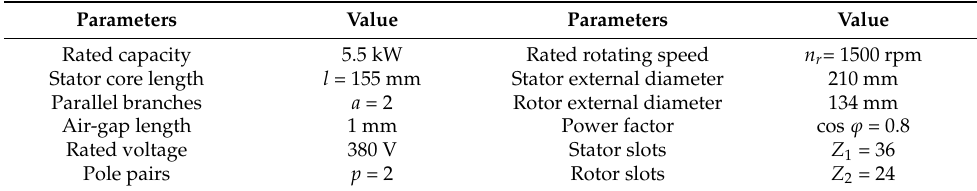
Table 2. Parameters of the DFIG Prototype